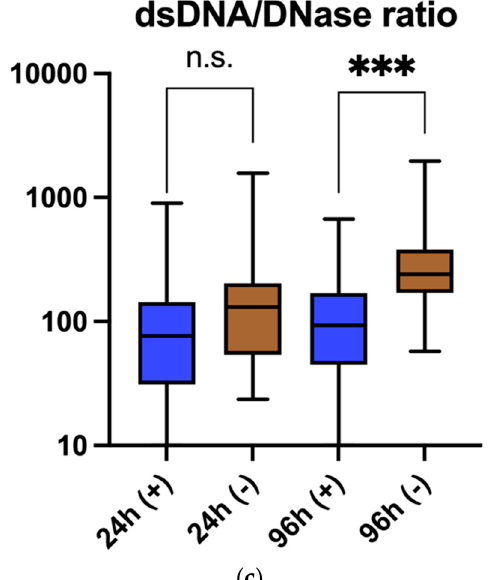
Figure 2. Boxplots comparing ( a ) dsDNA [ng/mL] after 24 and 96 h, ( b ) DNase [mU/mL] after 24 and 96 h, ( c ) dsDNA/DNase ratio after 24 and 96 h. Abbreviations: 24 h (+): value after 24 h in patients alive/CPC < 3 after six months; 24 h ( − ): value after 24 h in patients deceased/CPC > 2 after six months; 96 h (+): value after 96 h in patients alive/CPC < 3 after six months; 24 h ( −